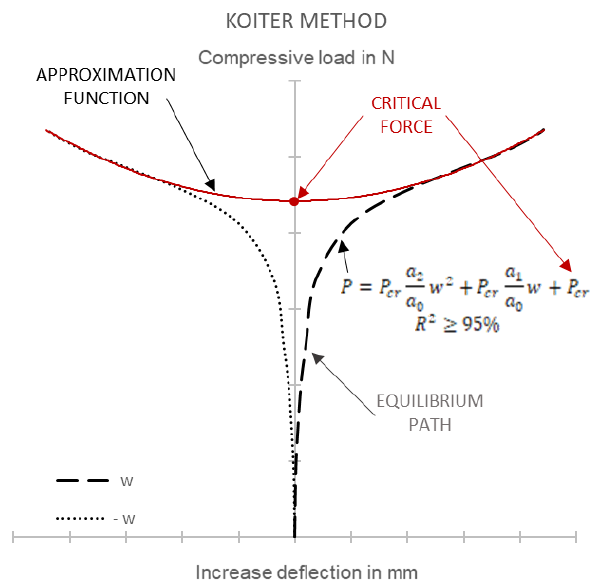
Figure 7. Equilibrium path approximation using Koiter’s method .